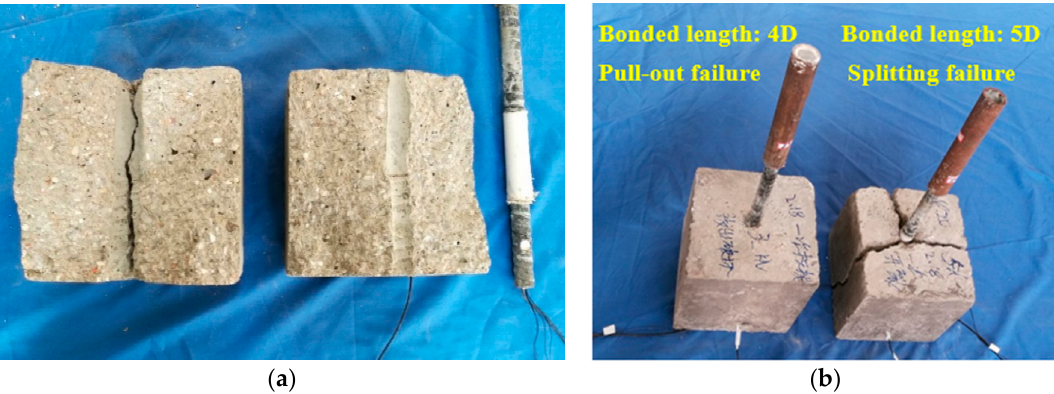
Figure 10. Different forms of failure: ( a ) the interface failure of the 5D specimen (splitting failure); ( b ) different forms of failure.